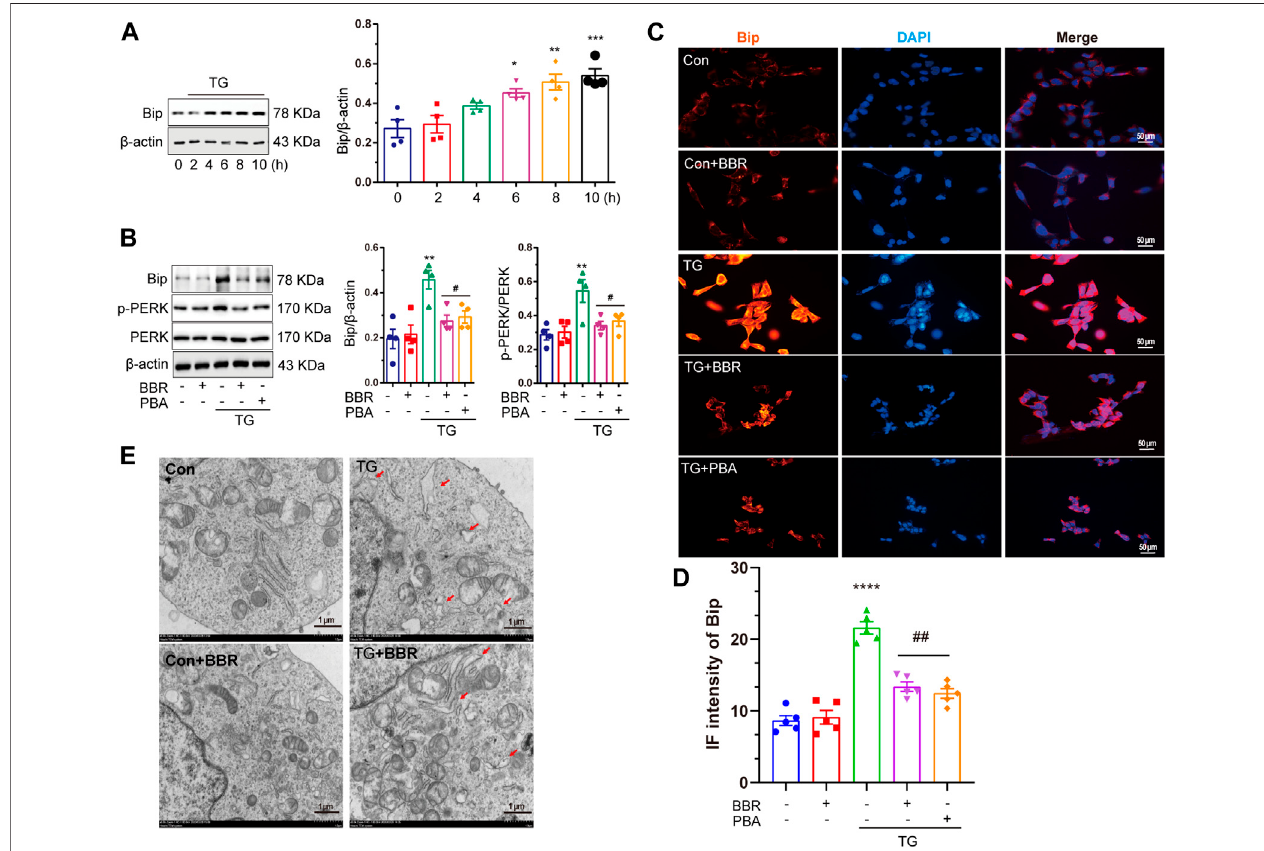
FIGURE 5| Berberine mitigates ERstress induced by thapsigargin in HT22/APP cells. (A) Western blot detection of Bip in TG-induced HT22/APP cells at different treatment time points and quantitative analysis. (B) Western blot detection of Bip, p-PERK, and PERK in TG-induced HT22/APP cells with or without PBA or BBR and quantitative analysis. (C) Representative immuno fl uorescence images of Bip in TG-induced HT22/APP cells. Scale bar is 50 μ m. (D) Quanti fi cation of IF of Bip. (E) RepresentativeTEMimages oftheendoplasmicreticulum structure inTG-induced HT22/APPcells.Scale baris1 μ m.Datawerepresented asmeans ± SEM.* p < 0.05, ** p < 0.01, *** p < 0.001, **** p < 0.0001 vs. Blank; # p < 0.05, ## p < 0.01 vs.